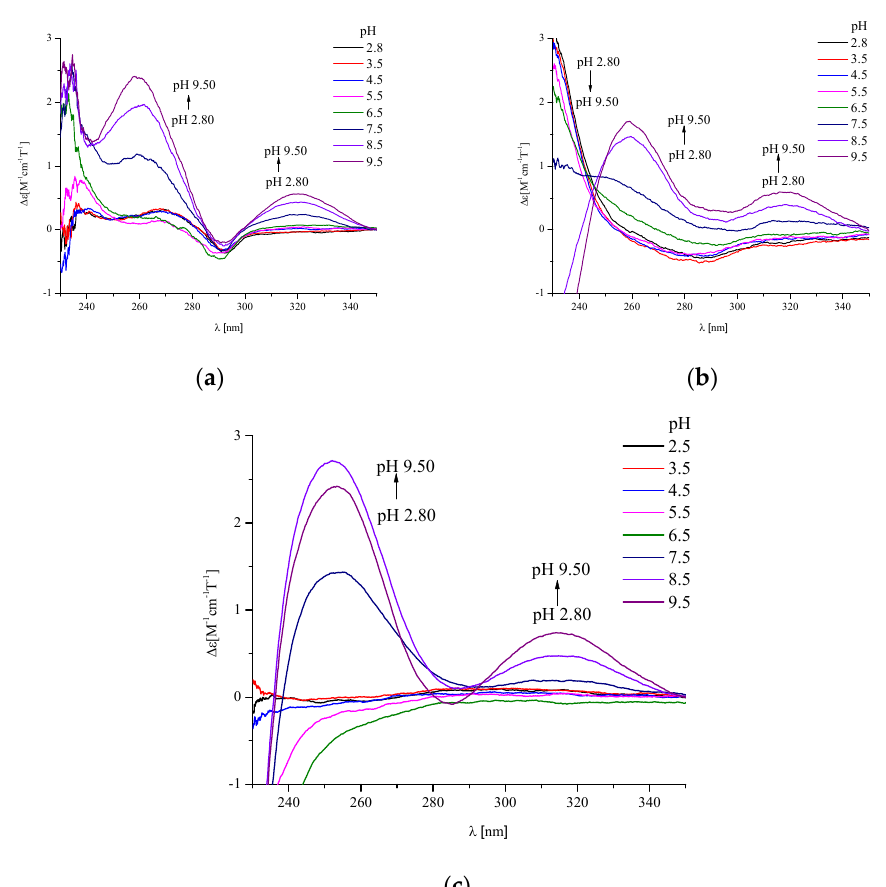
Figure 8. pH-dependent MCD corrected spectra of the systems: ( a ) Cu(II)/P2-P2 free; ( b ) Cu(II)/BCS-BCS free, ( c ) Cu(II)/P1-P1 free . The ligand concentration was 7×10 −4 mol/L and pH-metric titrations were performed in a 0.3 mol/L KCl solution. Sample volumes were 2.0 mL. The pH values were established by adding small amounts of concentrated KOH and HCl solutions.